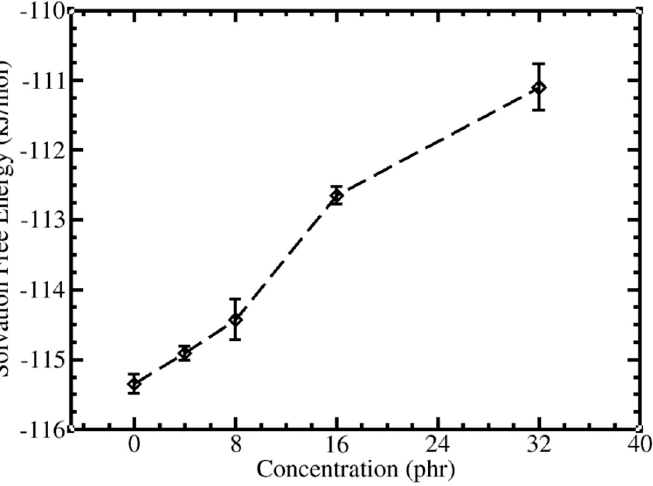
Figure 5. Solvation free energies of C 60 in cis -PI melt (0 phr) and cis -PI-C 60 composites at different C 60 concentrations. The dashed line is a guide to the eye.